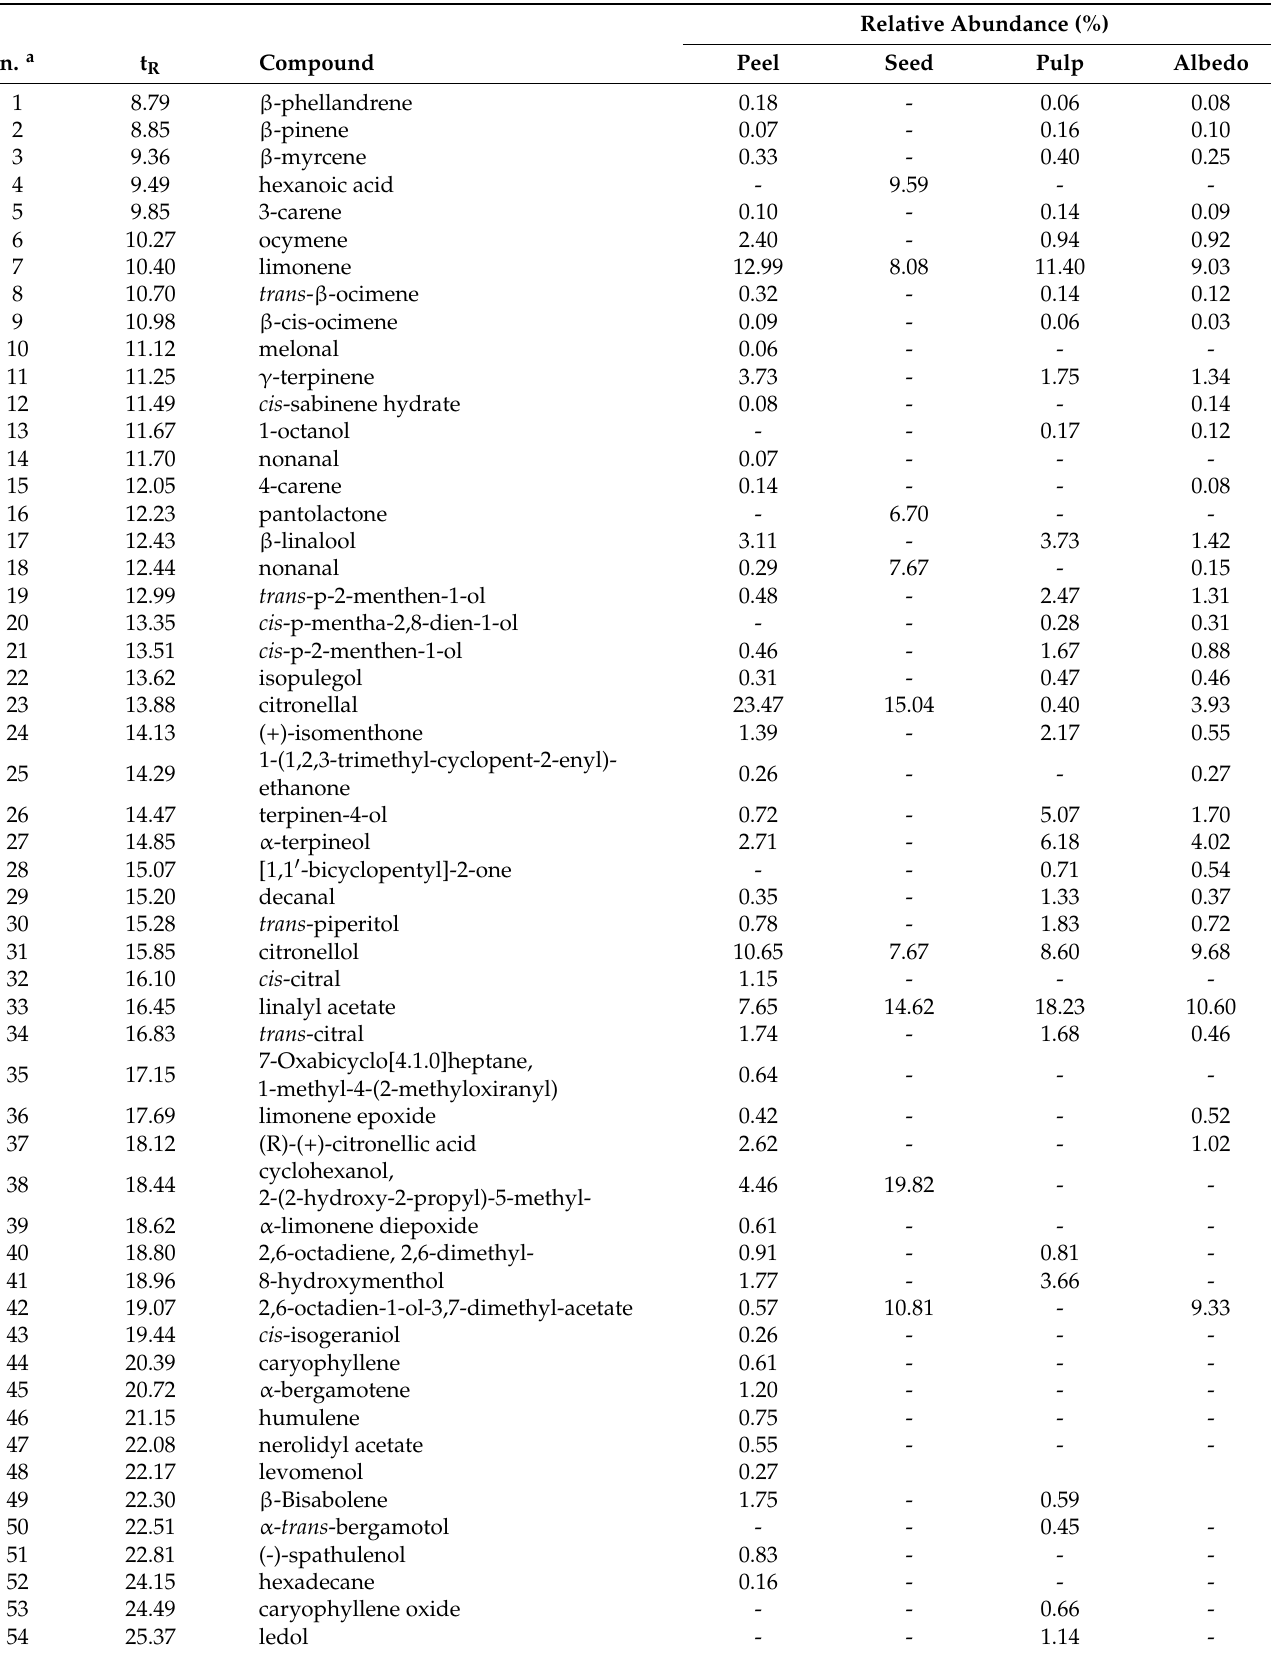
Table 1. GC-MS VOCs detected in peel, pulp, albedo, and seeds of Faustrime